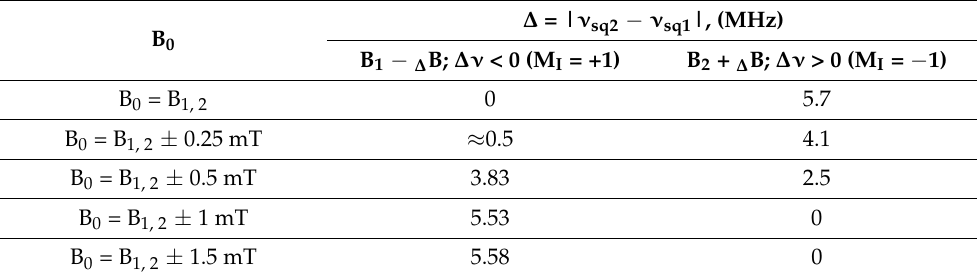
Table 3. Quantitative values of quadrupole interaction, depending on the external magnetic field